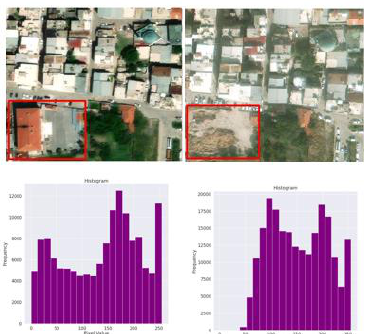
Figure 6. Pre-and after earthquake images (above), the